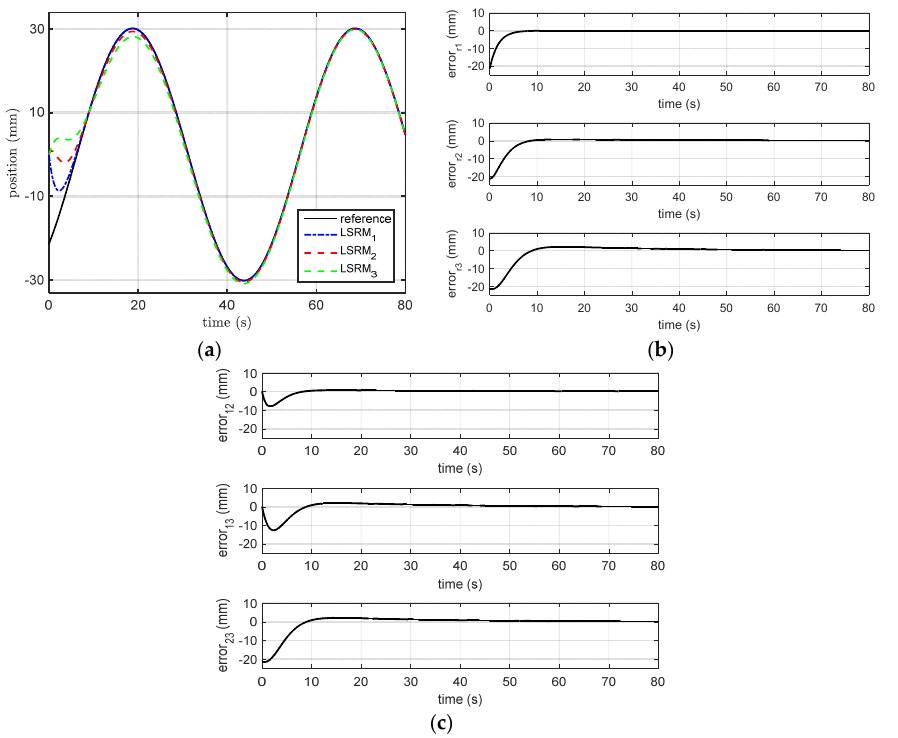
Figure 6. Simulation results ( a ) LSRMs; ( b ) error response to reference; and ( c ) relative error response between LSRMs with leader ‐ based feedback.